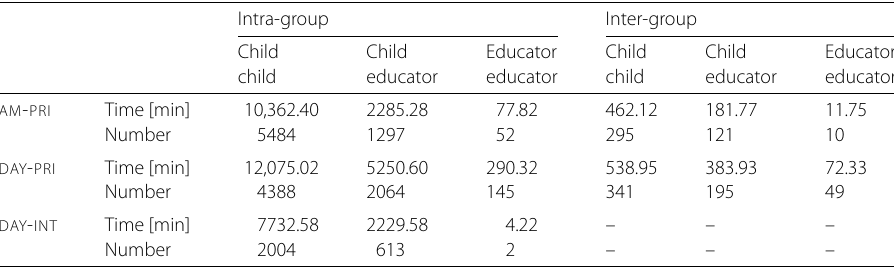
Table 5 Summary of the number and duration of the contacts in the three camps according to the social bubble strategy. For each camp AM - PRI , DAY - PRI , and DAY - INT , we report for the different bubbles the total time of contact and the number of contacts organized by the role of the participants Intra-group Inter-group Child